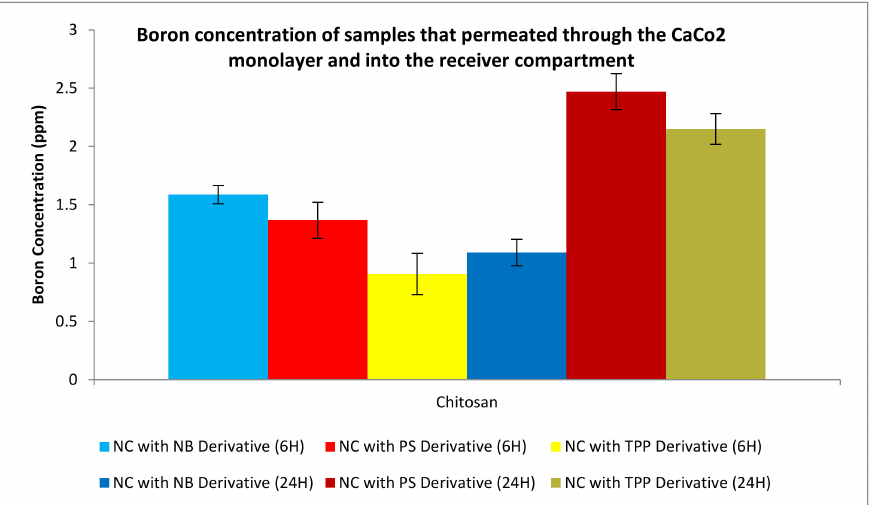
Figure 21. Boron concentration of compounds that have permeated through the cellular monolayer for nanocapsules (NC) formulated with chitosan and polypyrrole. Boron concentration for permeated boron was undertaken on compound 2 (TPP), compound 4 (NB), and compound 6